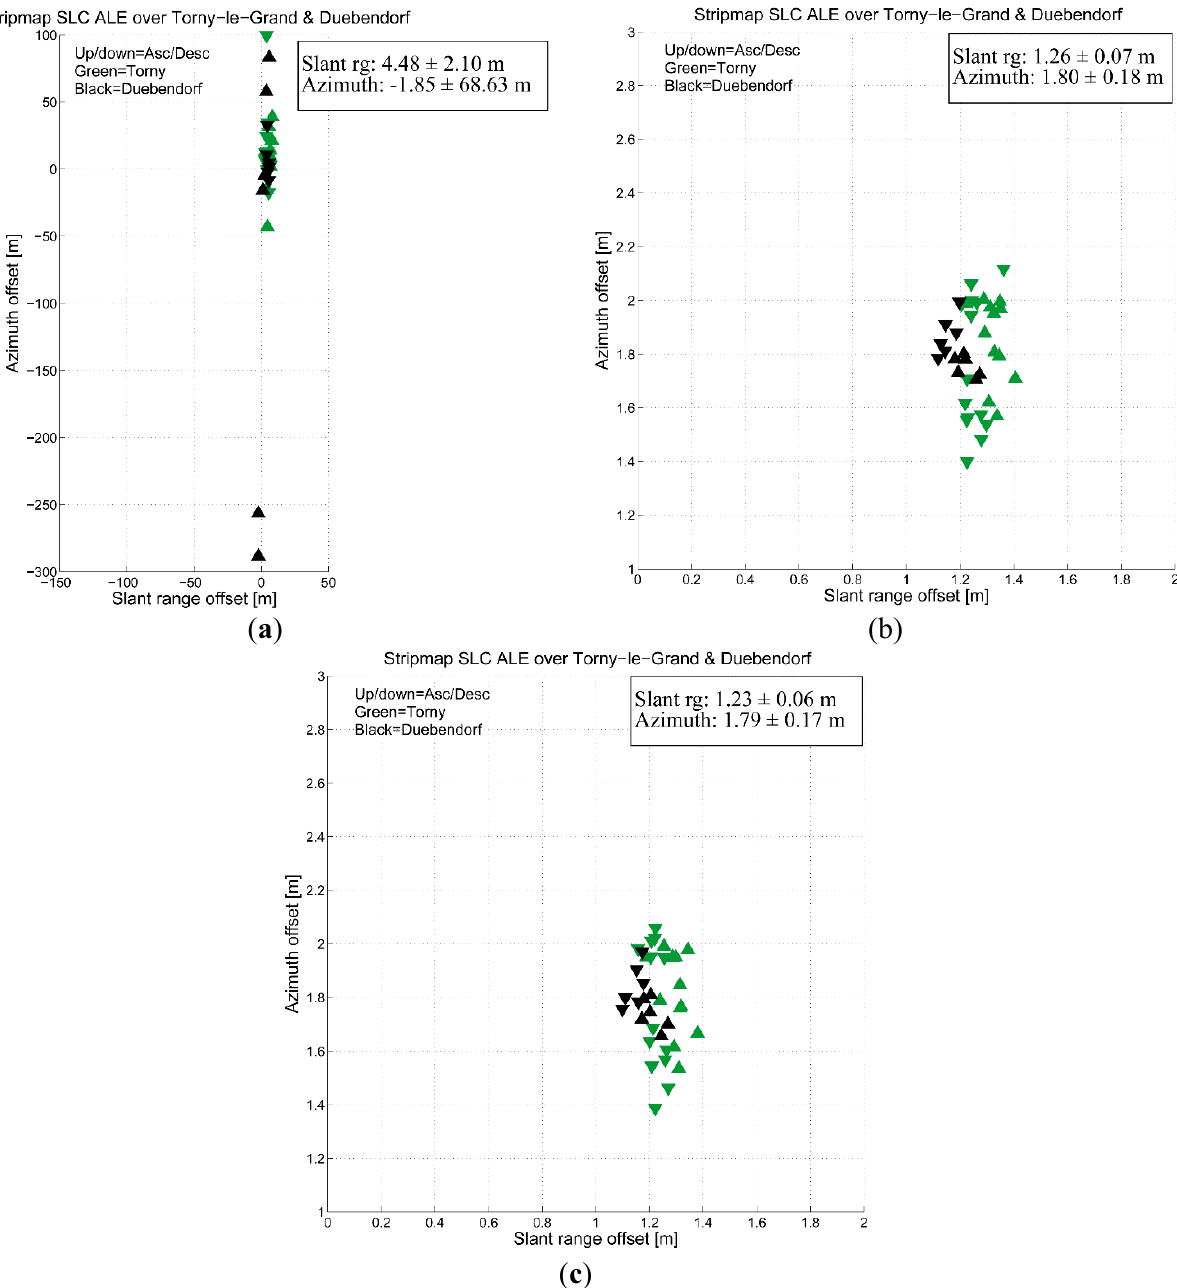
Figure 8. Comparison of StripMap SLC ALE estimates for different orbital state vector sources; path delay and bistatic residual correction applied in all cases; ( a ) predicted; ( b ) restituted; ( c ) precise (repeated from Figure 6c). (a) predicted OSVs; (b) restituted OSVs; (c) precise